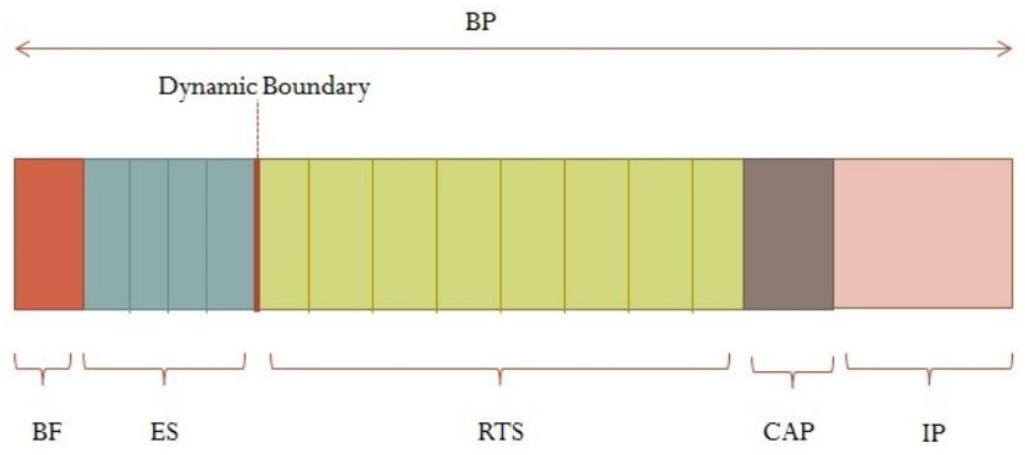
Figure 1. Proposed MAC Superframe